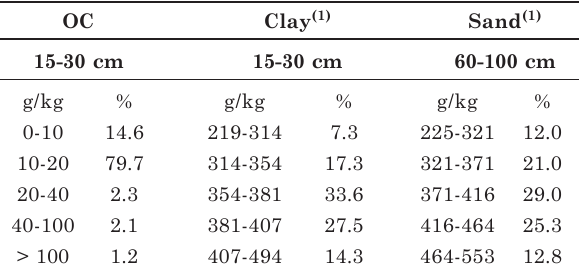
Table 6. Percentage distribution of area for OC, clay and